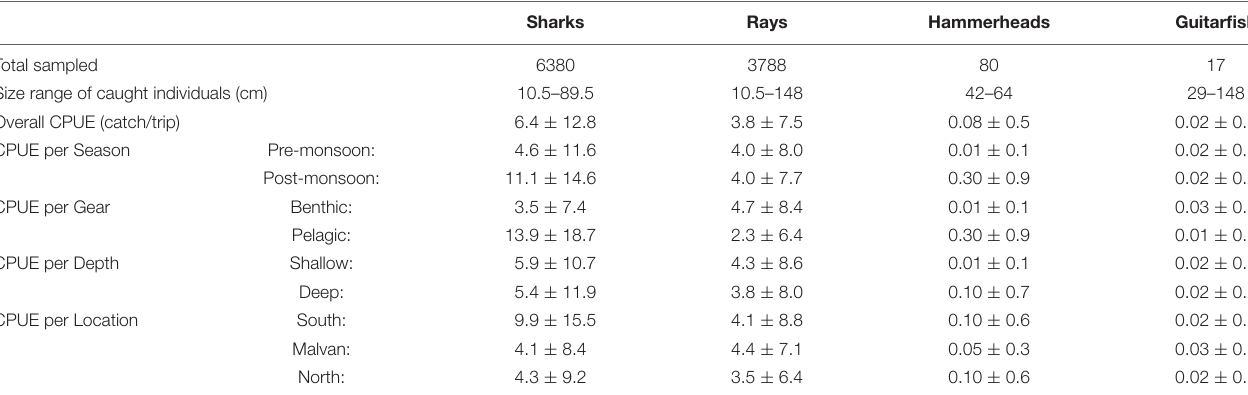
TABLE 3 | Summary of the elasmobranch landings data, given for sharks, rays, hammerheads and guitarfish. Sharks Rays Hammerheads